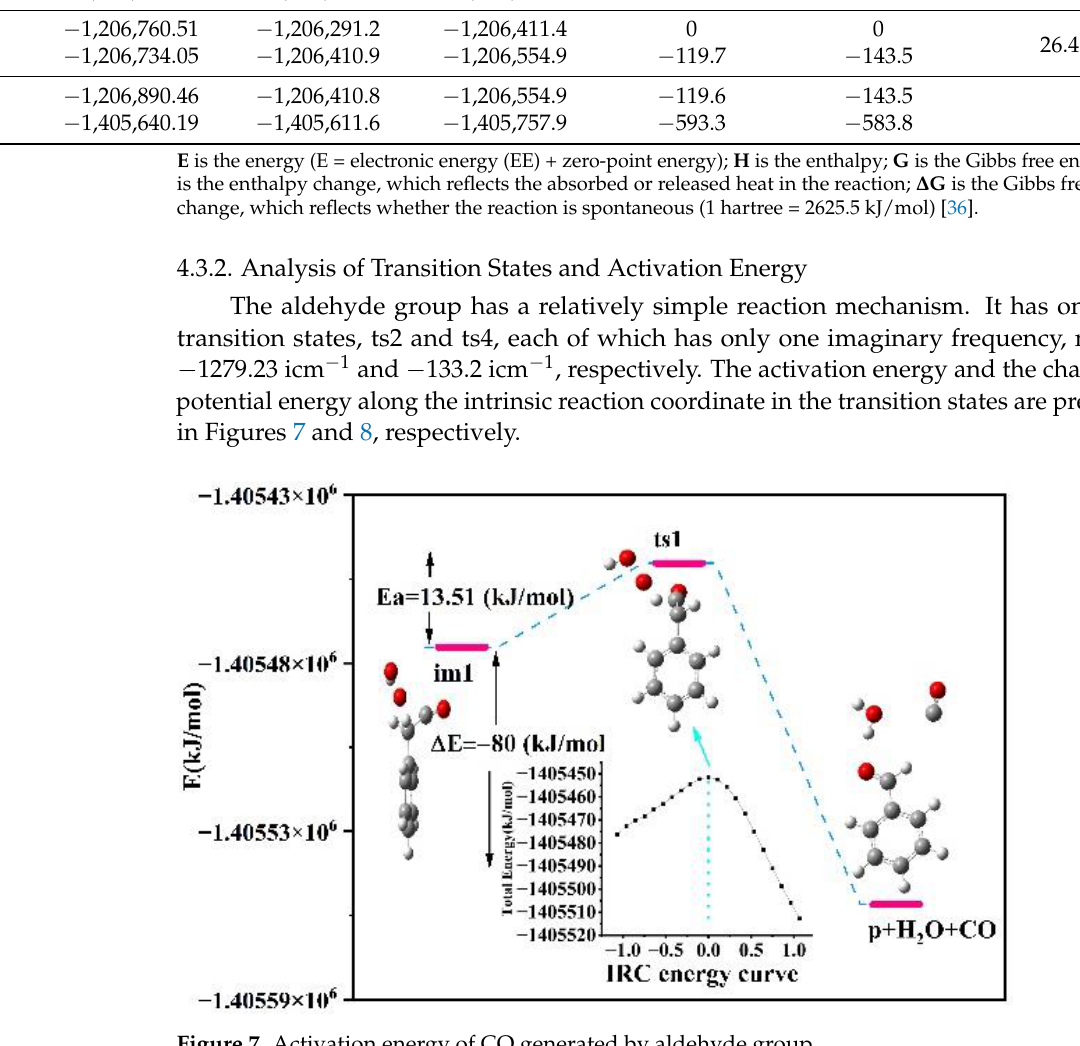
Figure 8. Activation energy of CO 2 generated by aldehyde group. As can be seen from Table 3 and Figure 7, as the oxidation proceeds continuously, methylene C-H in ph-CH 2 CHO breaks to generate the hydrogen radical, and then it grad- ually approaches the oxygen atom to form the ts2 structure. In this process, 16.51 kJ/mol of energy needs to be overcome. The ts2 rapidly generates the hydroxyl radical and quickly combines with -C-H· in ph-CH 2 CHO, so that the C-C bond in -C- C≡O is broken to release CO. Meanwhile, the hydroxyl radical attracts the hydrogen atom to generate wa- ter. According to Figure 3, from im1 to ts2, the adjacent C-C bond, C=O bond and O-O bond between the two hydroxyl radicals on the benzene ring do not change much, while the C-C bond connected between C=O increases to a length of 0.14 nm, ready to remove CO. In addition, the angle between H-O-H in im1 and p shrinks from 107° to 105°, during which water molecules are formed. It can be seen from Table 3 and Figure 8 that after removing the hydroxyl radical, im2 continues to oxidize the carboxyl radical. It needs to overcome 26.46 kJ/mol of energy to break the -C-C- bond to form extremely unstable ts4. As the angle of O=C=O in CO 2 gradually changes from 167° to 180°, CO 2 is released finally. The transition state has only one imaginary frequency. Moreover, the change in the reac- tion potential energy also verifies the rationality of the reaction path. Similarly, in the pro- cess of aldehyde group reaction, the activation energy of CO is lower than that of CO 2 . CO is first released in the low-temperature oxidation process of coal, and the release rate is higher than that of CO 2 . 4.4. Changes in CO and CO 2 Concentrations during Low-Temperature Oxidation Figures 9 and 10 show the change curves of CO and CO 2 concentrations of CQ and HYH coal samples during low-temperature oxidation (30 – 180 °C). The concentrations of CO and CO 2 are exponentially related to temperature with the rise in temperature. As illustrated in Figure 9, for the HYH coal sample, the initial generation temperature of CO is 60 °C and the inflection point temperature is 100 °C; for the CQ coal sample, the two temperatures are 80 °C and 120 °C, respectively, both being lower than those of the CQ coal sample. Moreover, the CO concentration of the HYH coal sample is much higher than that of the CQ coal sample. When the temperature reaches the inflection point, the CO